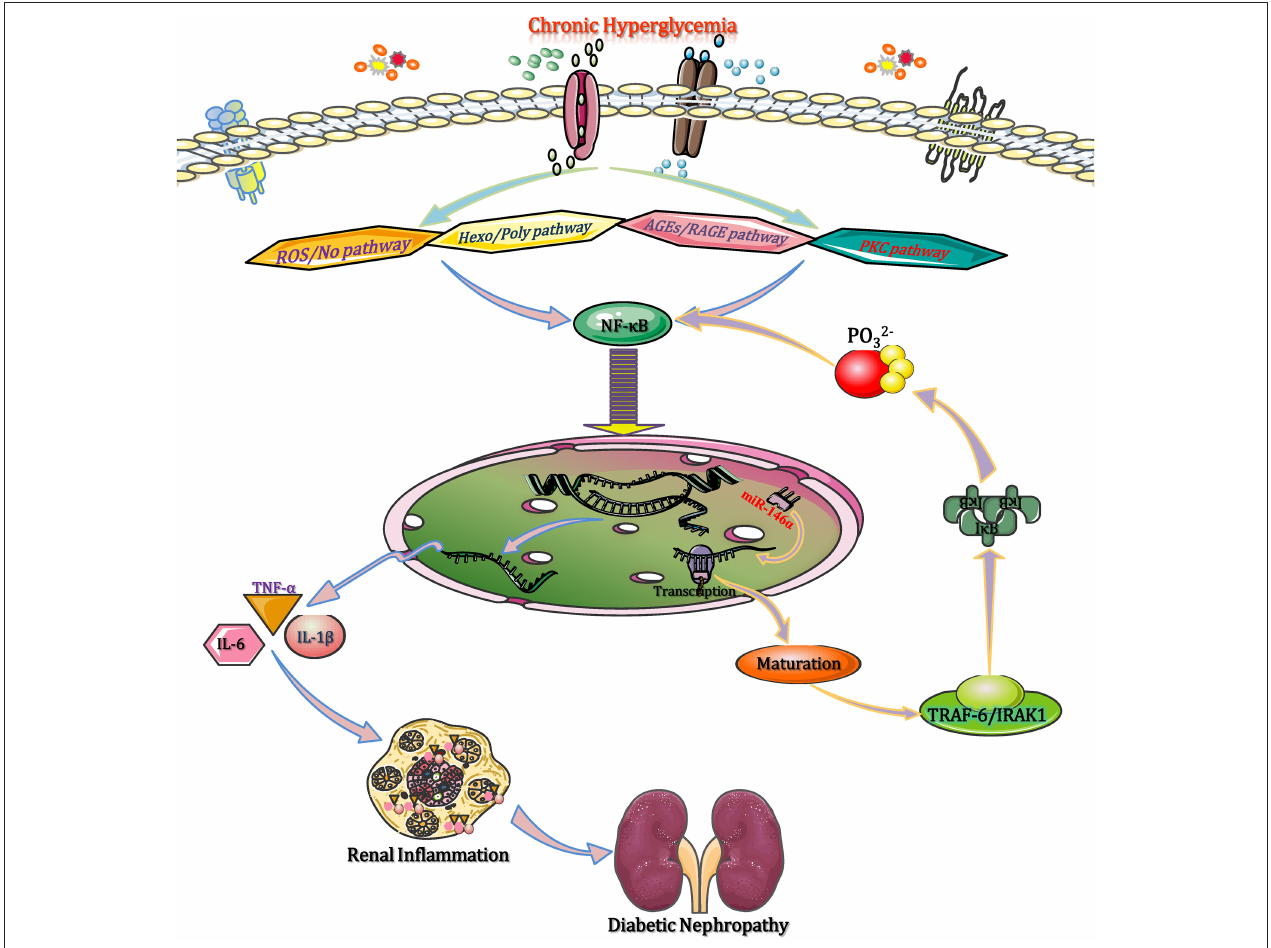
FIGURE 2 | miRNAs modulate monocyte/macrophage function to affect inflammation in DN. In the diabetic state, chronic hyperglycaemia activates NF- κ B through multiple intracellular signaling pathways, such as ROS/NO, AGE-RAGE, the Hexo/Poly pathway, and the PKC pathway. Then, NF- κ B moves into the nucleus to enhance the expression of several pro-inflammatory genes (TNF- α , IL-1 β , IL-6, and IL-18). These pro-inflammatory cytokines contribute to M1 macrophage polarization and NLRP3 inflammasome activation, causing macrophage infiltration and renal inflammation. NF- κ B binds to the 3 ′ -UTR of miR-146a to promote